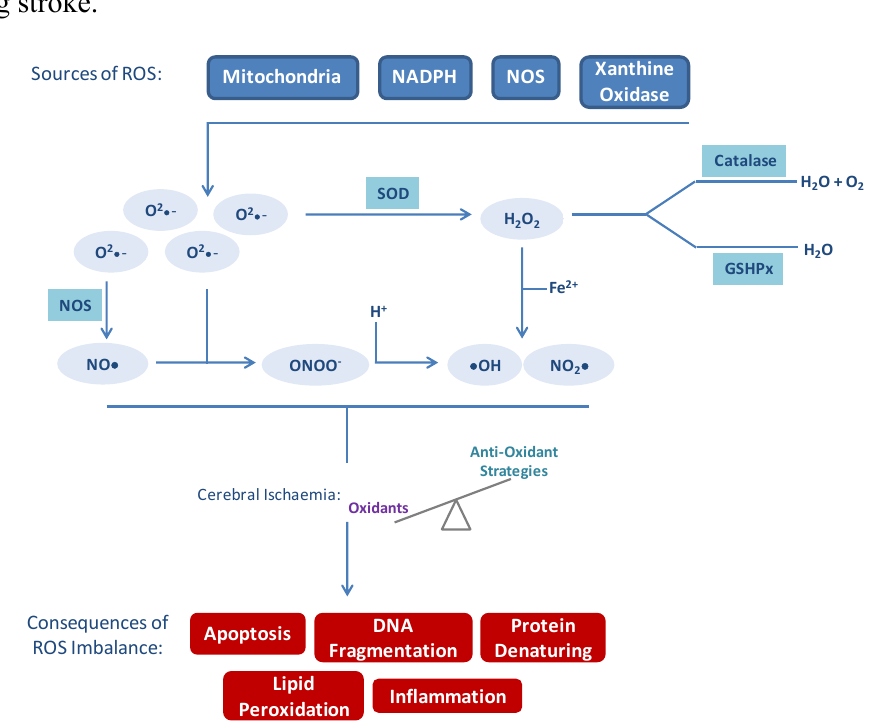
Figure 1. Sources of reactive oxygen species (ROS) and consequences of